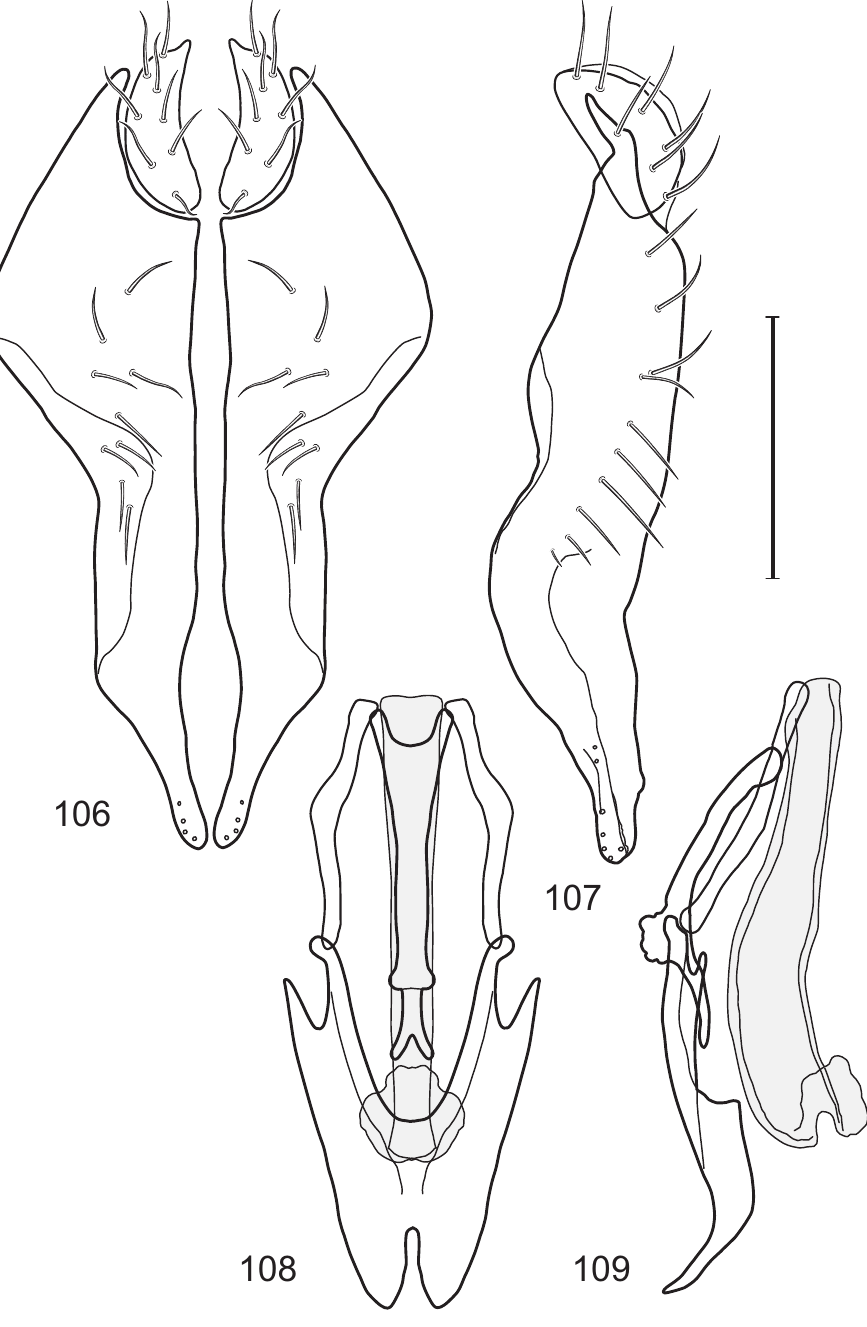
Figures 106–109. Hydrochasma octogonum sp. n. (Ecuador. Manabí: Pichincha) 106 epandrium and cerci, posterior view 107 same, lateral view 108 internal structures of male terminalia (aedeagus [shaded], phallapodeme, gonite, hypandrium), ventral view 109 same, lateral view. Scale bar = 0.1